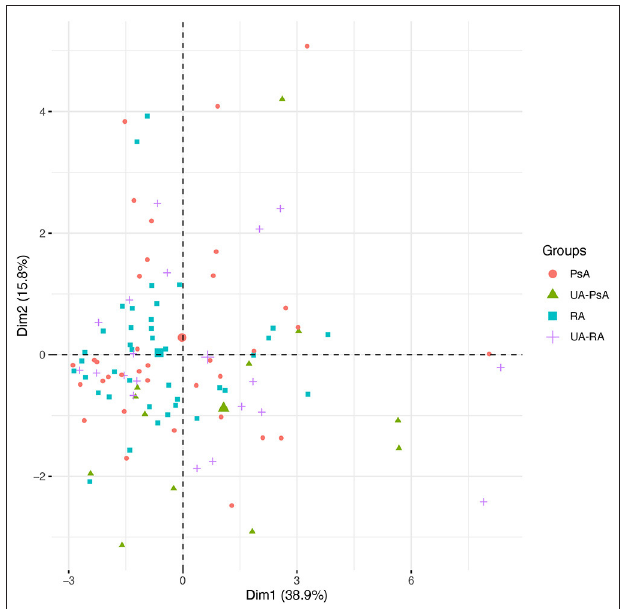
FIGURE 1 | Principal Component analysis (PCA). Distribution of samples according to the PC1 and PC2. The variables included were those that had no missing values or those with as maximum 1 missing value (which we impute): CD3 + T-cells, CD20 + B-cells, CD79 + B-cells, CD138 + plasma-cells, CD31 + endothelial cells, CD68 + lining macrophages, CD68 + sublining, CD79 + B-cells, CD15 + neutrophils, and CD117 + mast cells. Reducing the data dimensionality to the main PCs does not show a clear separation between any of the 4 groups of patients.